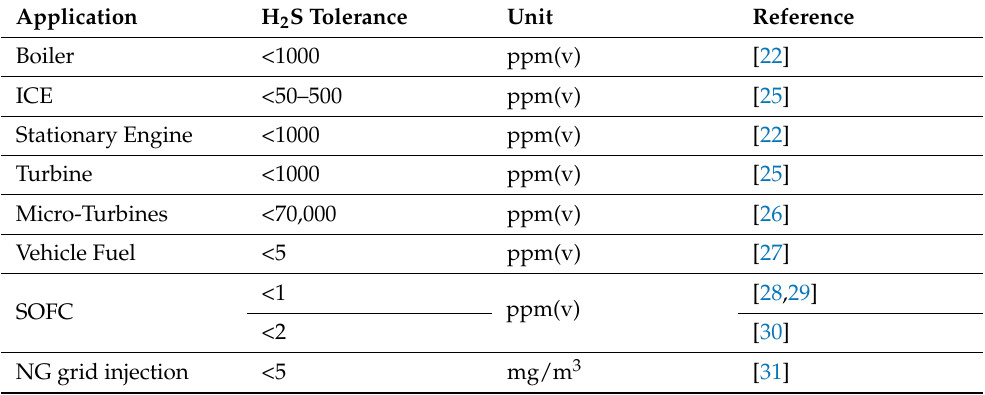
Table 1. H 2 S tolerances of the main biogas/biomethane